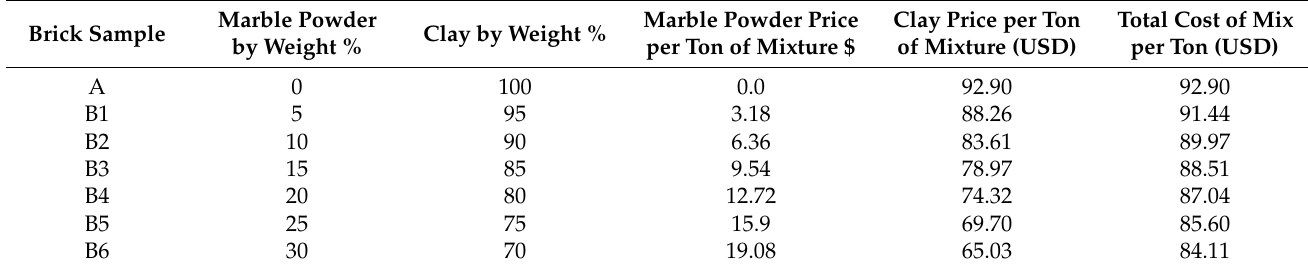
Table 3. Cost comparison of marble powder and